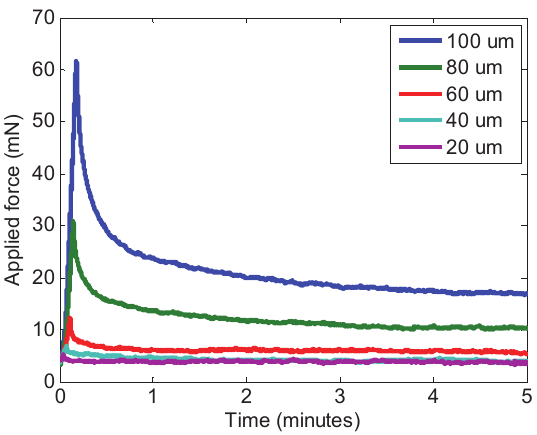
Fig. 14: Measured force during small strain indentation experiments on alginate hydrogel encapsulated fibroblasts. Legend denotes final indentation